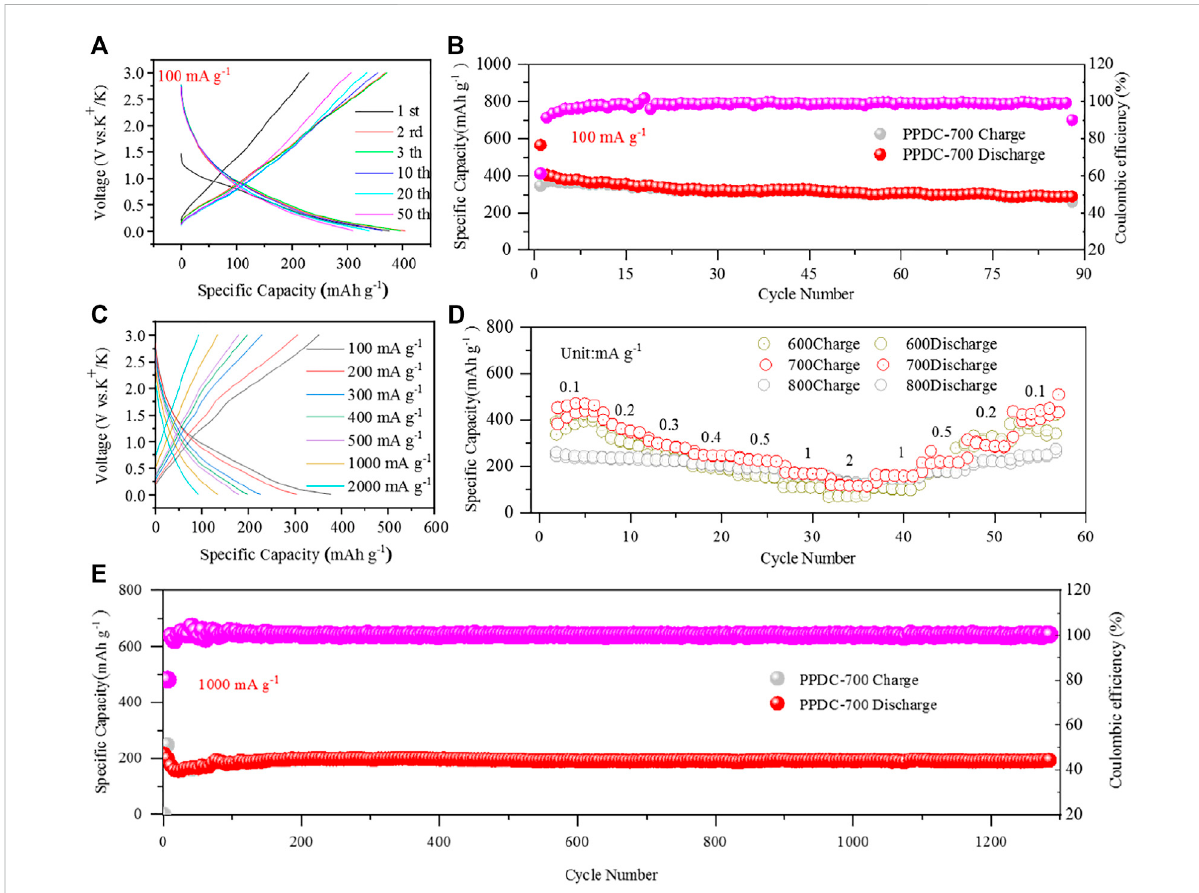
FIGURE 3 (A) Charge – dischargevoltagepro fi lesforselectedcyclesofthePPDC-700anodeatacurrentdensityof100 mA g − 1 ; (B) Cyclicperformancesof the PPDC-700 anode at 100 mA g − 1 ; (C) Charge – discharge voltage pro fi les of the PPDC-700 electrode at different current densities; (D) Rate capability of the PPDC-600, PPDC-700 and PPDC-800 anodes at different current densities; (E) Cyclic performances of PPDC-700 anode